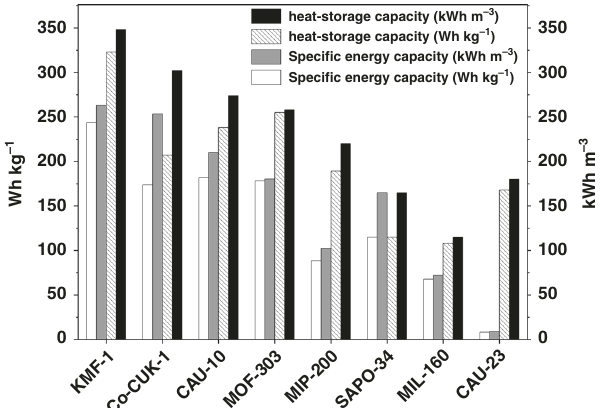
Fig. 5 Speci fi c energy capacities and heat-storage capacities for KMF-1 and benchmark adsorbents expressed in gravimetry and volumetric scales. Boundary conditions: heats transferred from the evaporator in one cooling cycle at T ev = 5 °C, T ads = 30 °C, T con = 30 °C, and T des = 70 °C (white and gray bars) and heat-storage capacity at T ev = 10 °C, T ads = 30 ° C, T con = 30 °C, and T des = 70 °C (dashed and dark gray bars). White and dashed bars denote the gravimetric heats (Wh kg − 1 ), while gray and dark gray bars indicate the volumetric heats (kWh m − 3